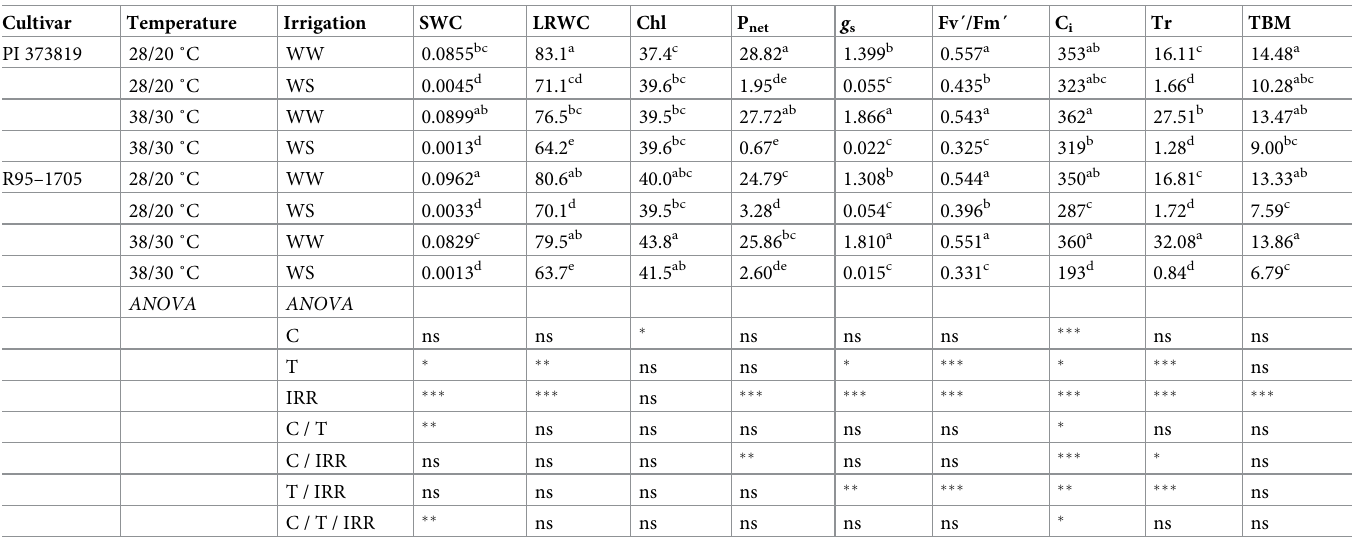
Table 1. Temperature (T) and irrigation (IRR: well-watered, WW; water stressed, WS) effects on soil water content (SWC, m 3 m -3 ), leaf relative water content (LRWC, %), chlorophyll concentration (Chl, μ g cm -2 ), photosynthetic rate (P net , μ mol CO 2 m -2 s -1 ), stomatal conductance ( g s , mol H 2 O m -2 s -1 ), chlorophyll fluores- cence (Fv´/Fm´), internal CO 2 concentration (C i , μ mol CO 2 mol -1 ), transpiration (Tr, mmol H 2 O m -2 s -1 ), and total biomass (TBM, g plant -1 ) of two soybean culti- vars (C) between 48 and 50 days after emergence.